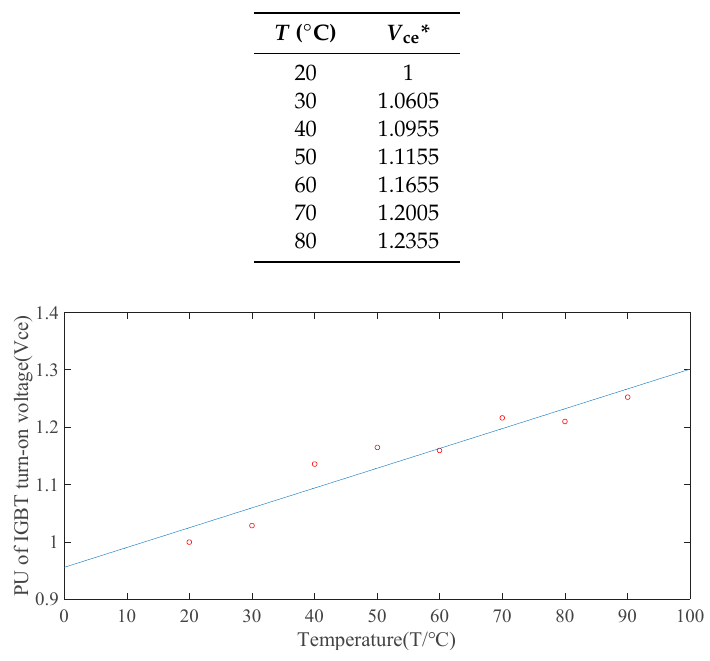
Figure 14. A function fitting diagram of V ce* and T. Table 4. Comparison of V ce at different temperatures.